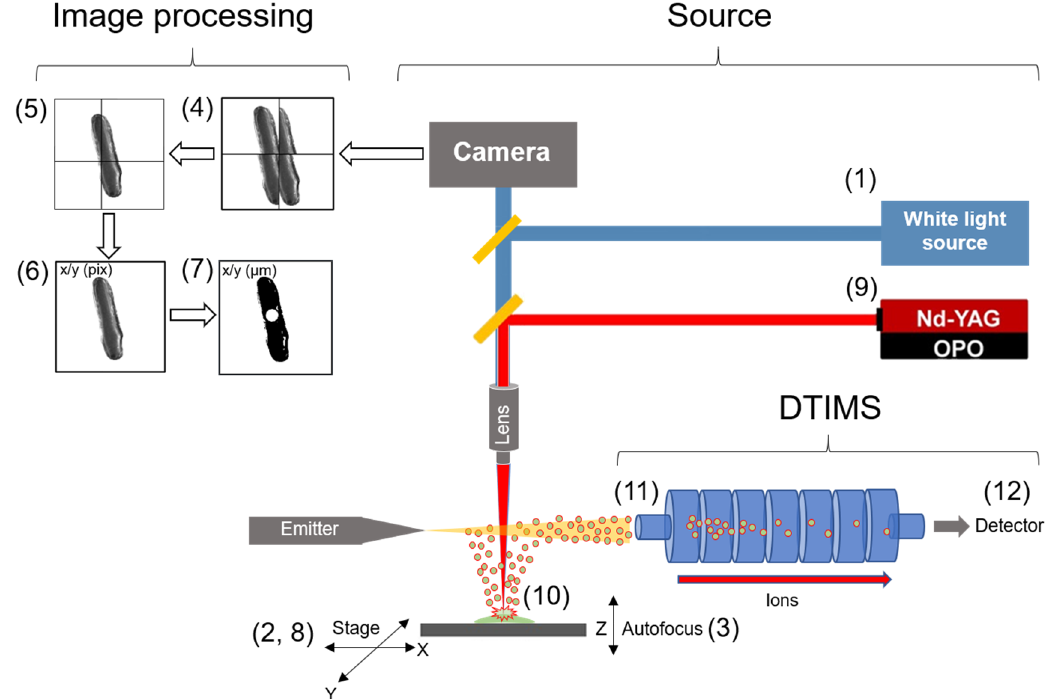
Figure 1. Schematic of LAESI-DTIMS based microscope system and its use. (1) A white light source is directed to the sample surface. (2) The Peltier-cooled stage moves to a sample position. (3) The microscope software performs autofocusing at the sample position by fine adjustment of the stage in the Z axis and records an image, then the stage moves in X/Y to an adjacent area to collect an image array with a specified number of tiles. (4) Image tiles are aligned. (5) Image tiles are overlapped and stitched together. (6) image coordinates (pixels) are converted to stage coordinates (µm) using a home built LabView software. (7) Cell center coordinates (X/Y µm) are extracted, and a list of cell centers coordinates are entered into the LAESI-MS microscope software. (8) The stage moves sequentially to each cell centroid coordinate. (9) When the stage arrives at a cell centroid the MS sends a trigger to the laser to fire upon the ion trap opening. (10) The ion trap opens, the targeted cell is ablated, and endogenous molecules are intercepted by the electrospray and directed into MS inlet. (11) Ion packets are accumulated in the quadrupole trap and injected into DTIMS. (12) Ions are separated in the gas phase according to electrophoretic mobility and mass over charge of each ion is recorded by the TOF-MS.